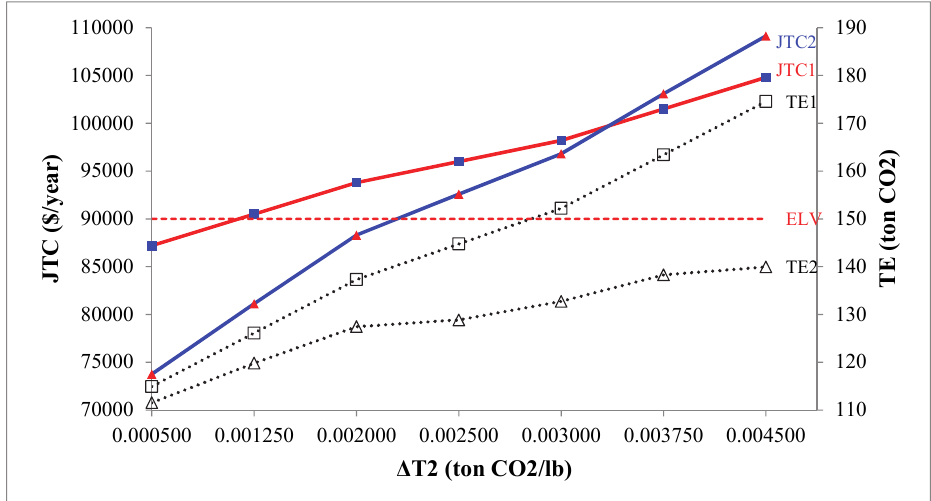
Fig. 15. Effect of changing in transport direct emission factor on total